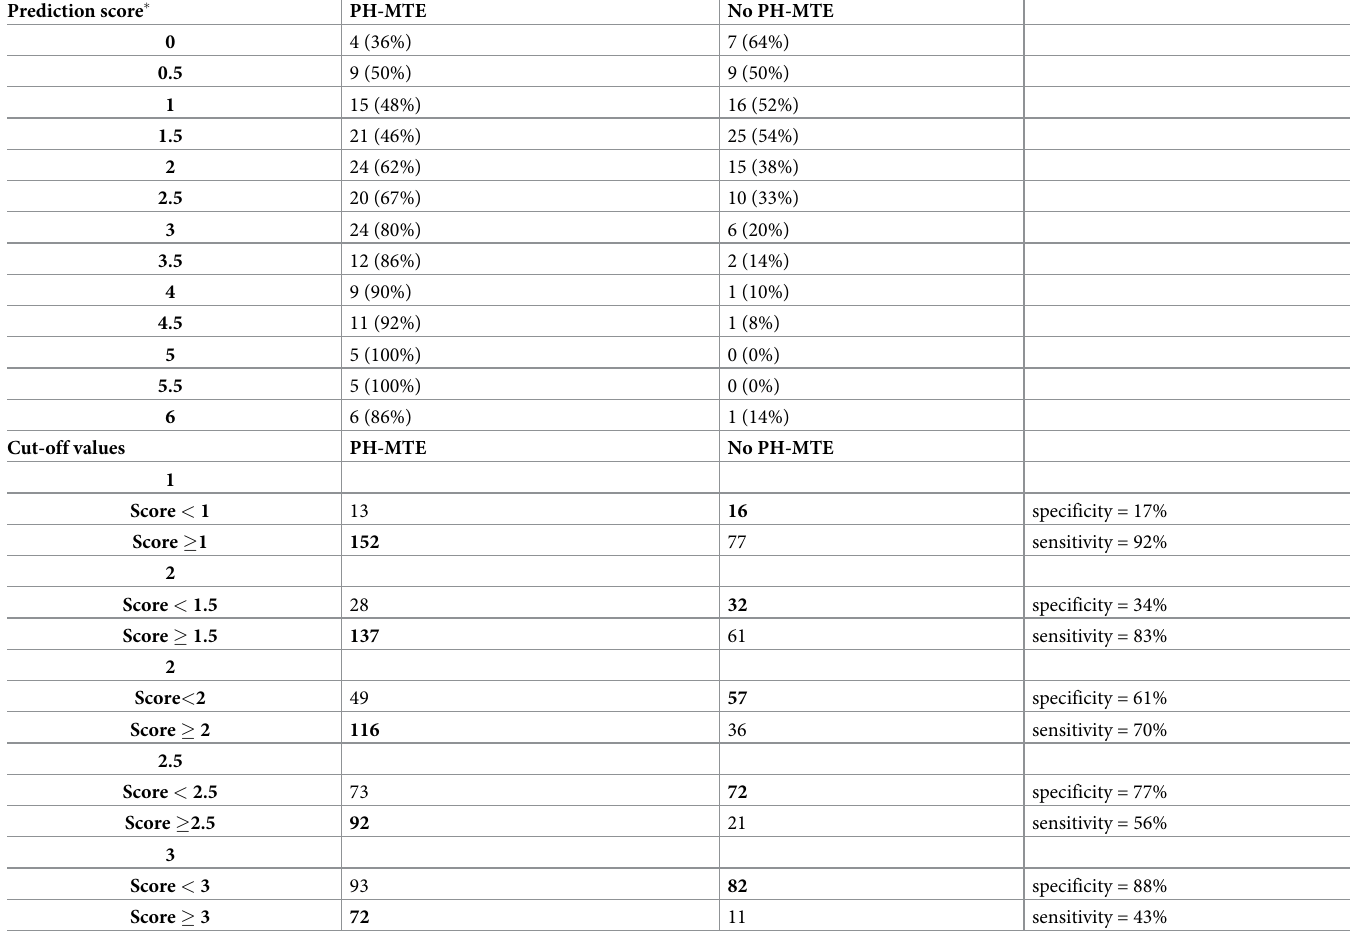
Table 3. Prediction scores and cut-off values for high risk of potential harmful medication transfer errors (PH-MTE) or not (No-PH-MTE). Prediction score �